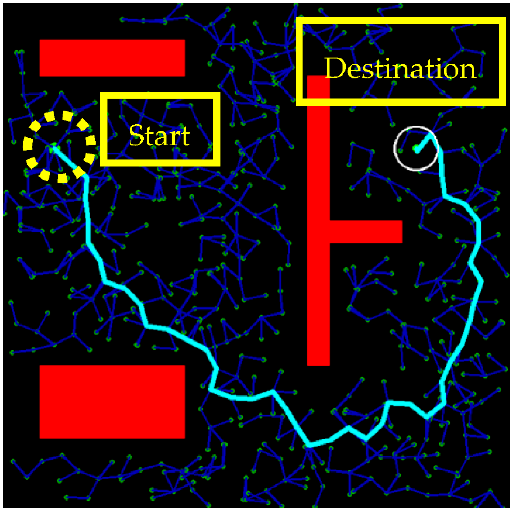
Figure 1. Illustration of the RRT algorithm with the tree expanding from the start x start on the upper left to the destination x dest on the upper right. The thin lines and points are the roots of the searching tree and the thick line is the path predicted by the algorithm. Note that the predicted path has many redundant points, unnecessary turns, and small curvatures infeasible for vehicle operation.